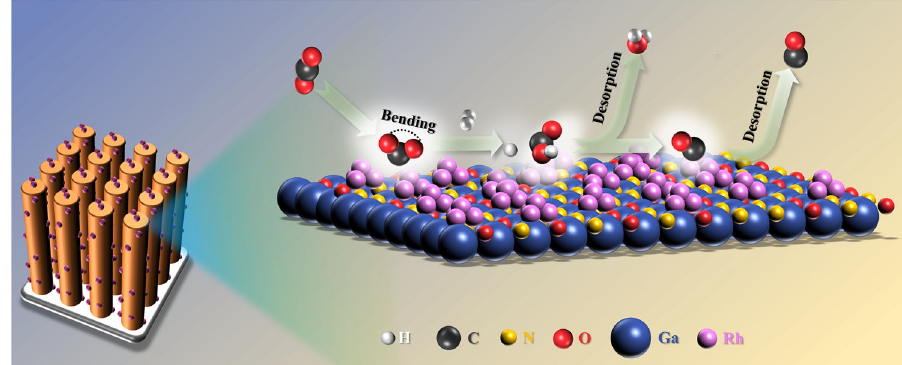
Fig. 6 Catalytic mechanism. Schematic illustration of CO 2 hydrogenation mechanism on the interface of Rh/GaN 1 – x O x